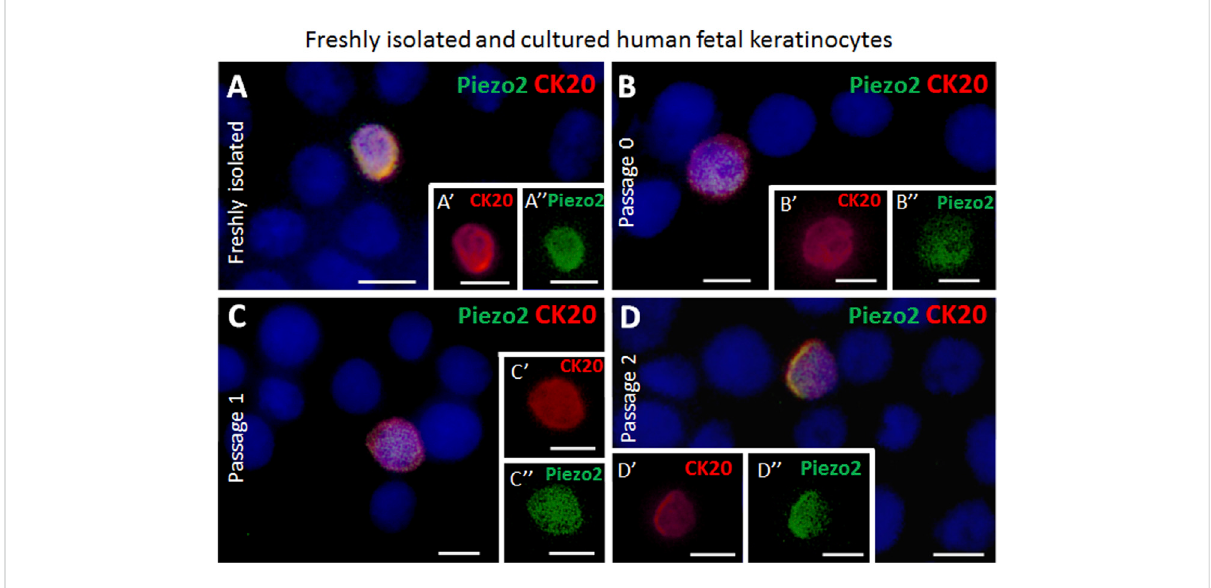
FIGURE 3 Examples of immuno fl uorescence staining for Piezo2 of freshly isolated and cultured cytospinned epidermal keratinocytes from human fetal skin. (A,A 9 ,A 0 ) Piezo2(green)isexpressedinaCK20-positive(red)Merkelcellinfreshlyisolatedkeratinocytes. (A 9 ) depictsasmagni fi cationtheCK20- positive (red) Merkel cell shown in (A) . (A 0 ) highlights the Piezo2 (green) expression in the Merkel cell in (A) . (B,B 9 ,B 0 ) Piezo2 (green) is expressed in a CK20-positive (red) Merkel cell in culture (Passage 0). B 9 and B 0 show only the CK20 (red) or Piezo2 (green) expression of the Merkel cell displayed in (B) . (C,C 9 ,C 0 ,D,D 9 ,D 0 ) Piezo2(green)isstillexpressedinCK20-positive(red)Merkelcellsincultured cellsinhigher passages(passage1in C , C 9 , C 0 ,andpassage2in D , D 9 ,D 0 ). C 9 , D 9 , C 0 , D 0 displaysinglestainingofPiezo2(green)orCK20(red)oftheCK20-positiveMerkelcellin (C) and (D)